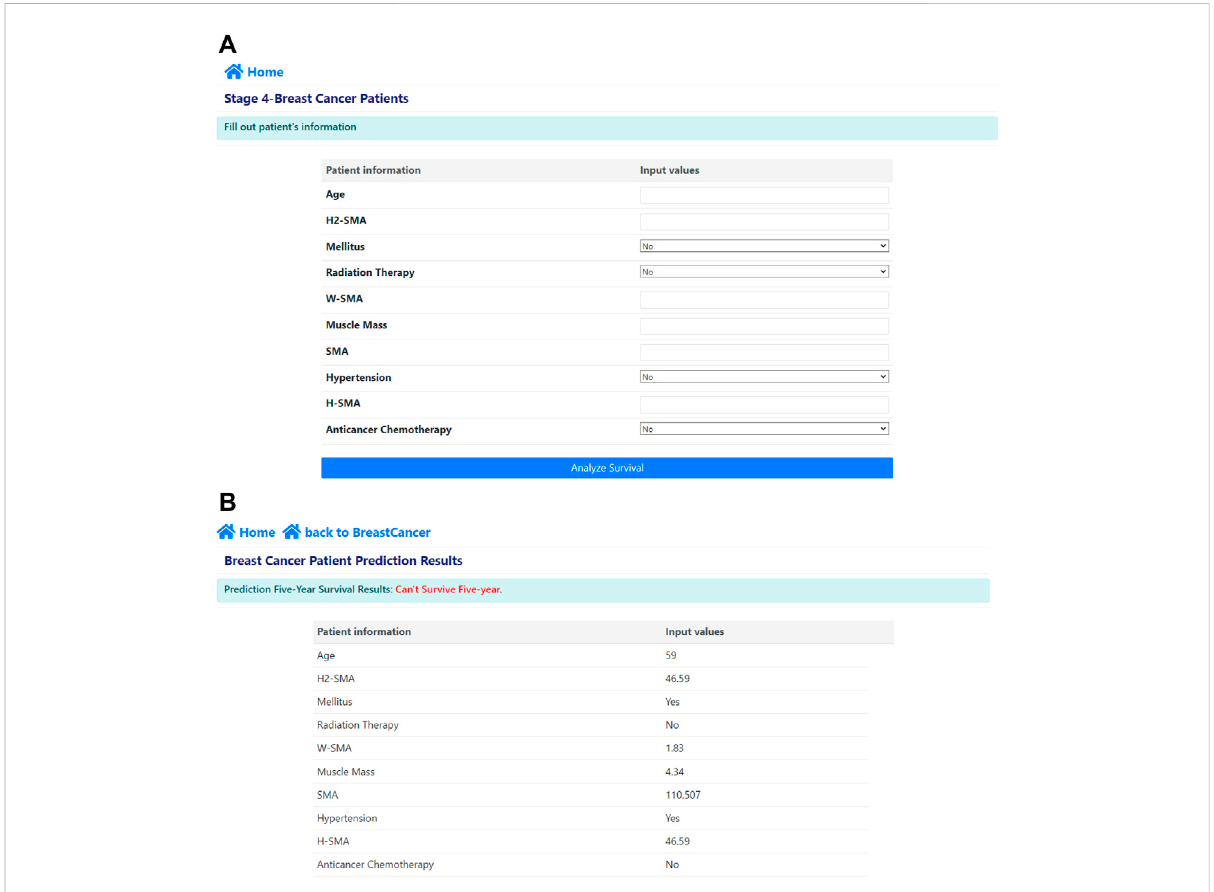
FIGURE 4 Our deployed web application: (A) input windows where the user inputs the patient ’ s data and (B) the predicted fi ve-year survival results after entering the patient ’ s